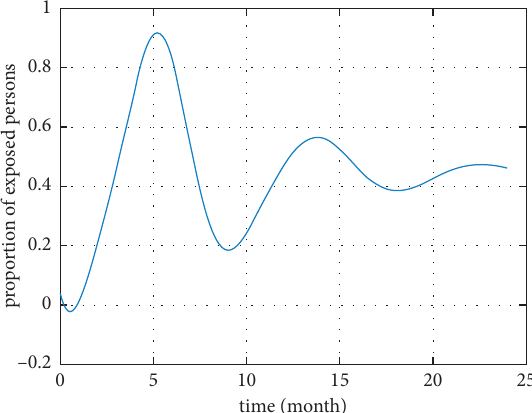
Figure 9: Proportion of the exposed curve from the